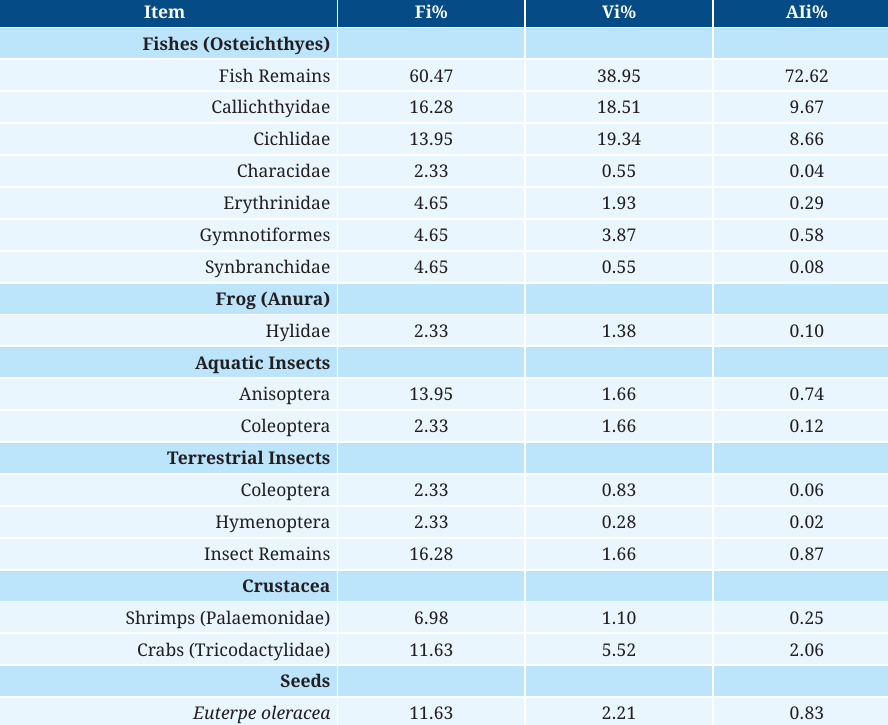
TABLE 1 | Preys consumed by Electrophorus varii in the Curiaú River EPA, state of Amapá, Brazil. Fi% = Frequency of Occurrence, Vi% = Volume and AIi% = Alimentary